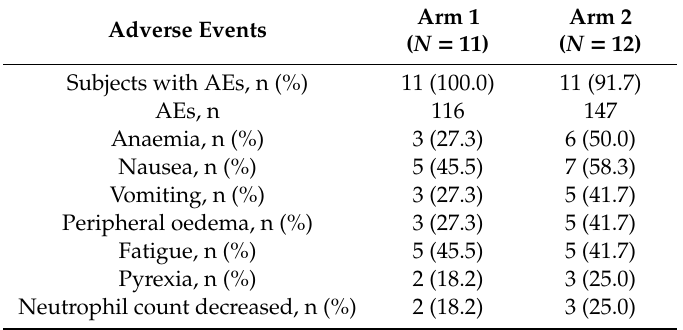
Table 2. Adverse events during the treatment period (Safety analysis set, N = 23). Adverse